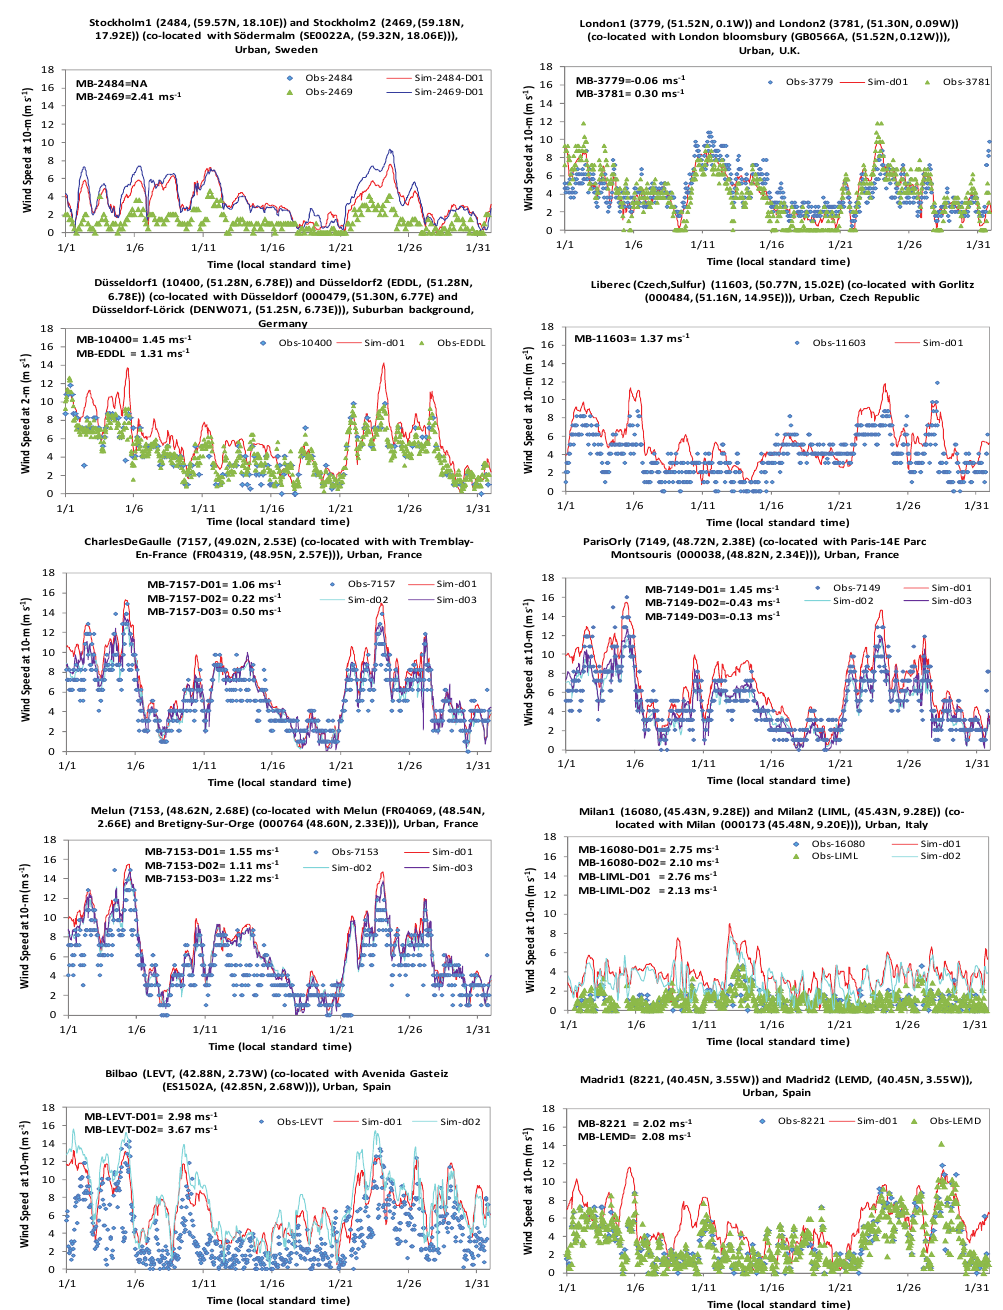
Figure 12. Simulated and observed 10-m wind speed in January 2001 at selected sites. Statistics is not available (NA) at one site (Stockholm 1) where observations were not available.